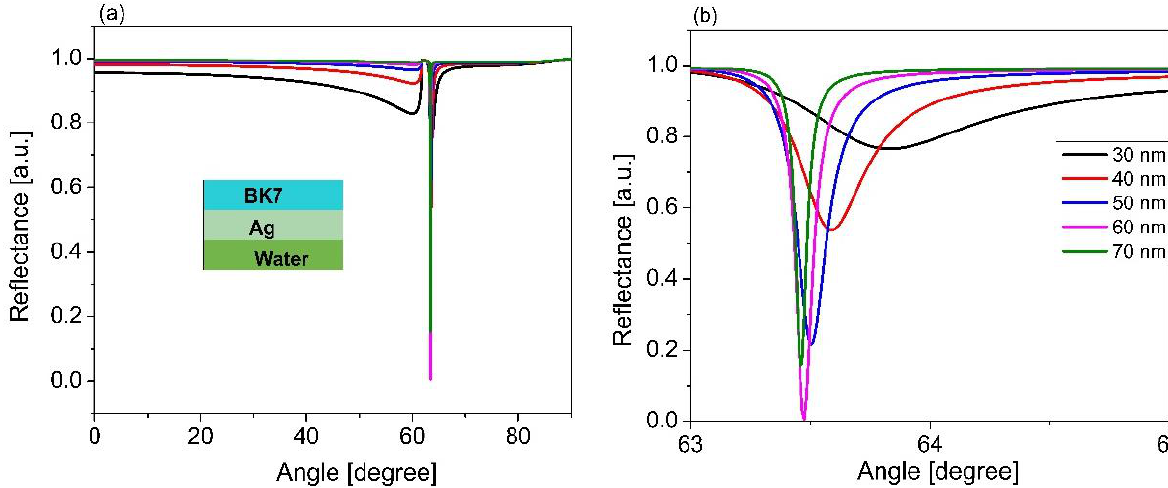
Figure 2. ( a ) Simulated results of Ag thickness from 30 nm to 70 nm; ( b ) magnified view of ( a ) from 63 to 65 degrees.